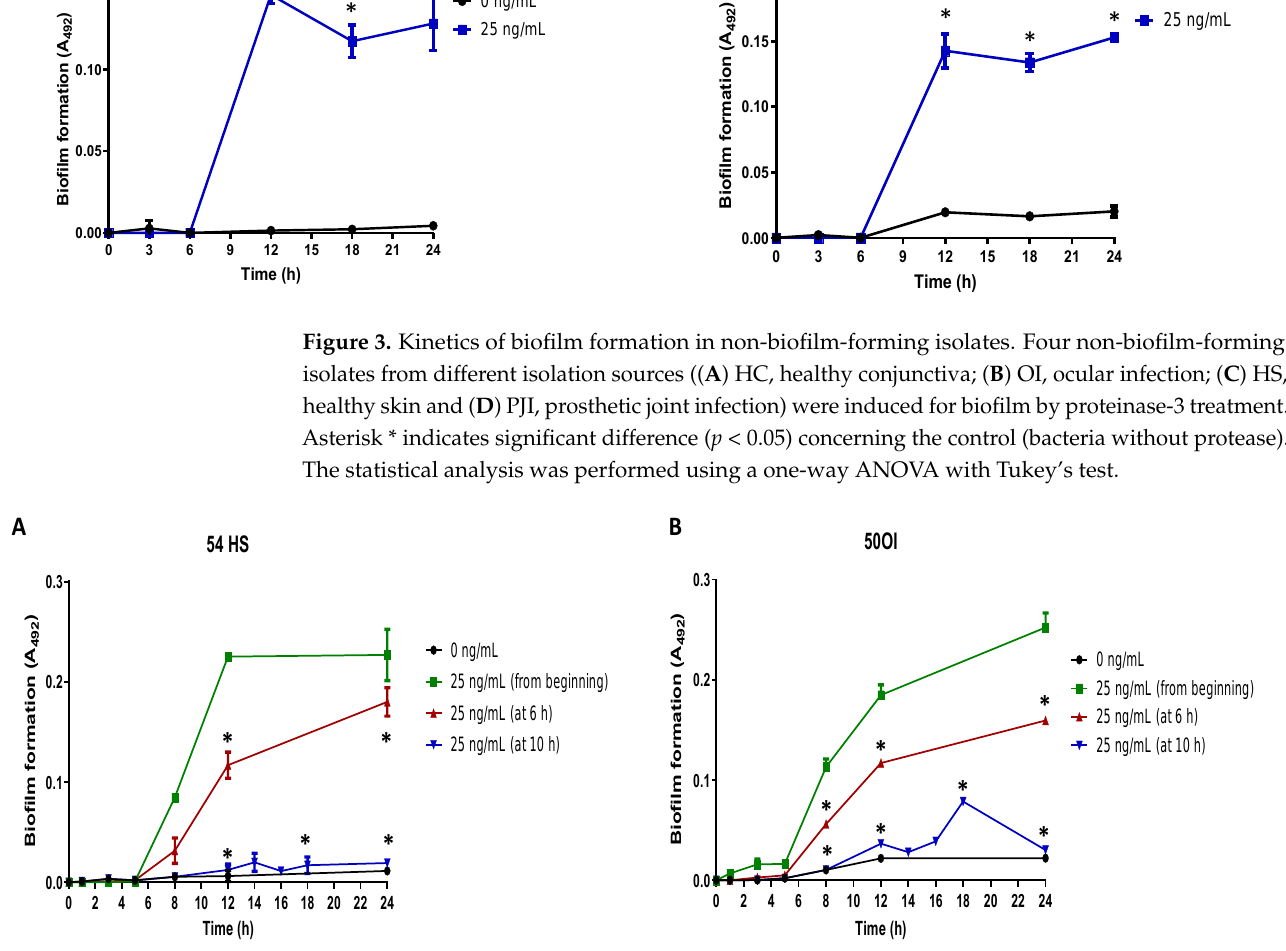
Figure 4. Proteinase-3 addition at different stages of biofilm formation. Biofilm forming kinetics of a commensal (HS, healthy skin, panel ( A )) and a clinical (OI, ocular infection, panel ( B )) non- biofilm-forming isolate was done in the presence of proteinase-3 added at 6 or 10 h. The abundance of biofilm was determined according to Christensen et al. sampling at different points of the kinetics. Asterisk * indicates a significant difference ( p < 0.05) concerning the bacteria with proteinase-3 since the beginning of the culture. The statistical analysis was performed using a one-way ANOVA with a Tukey’s